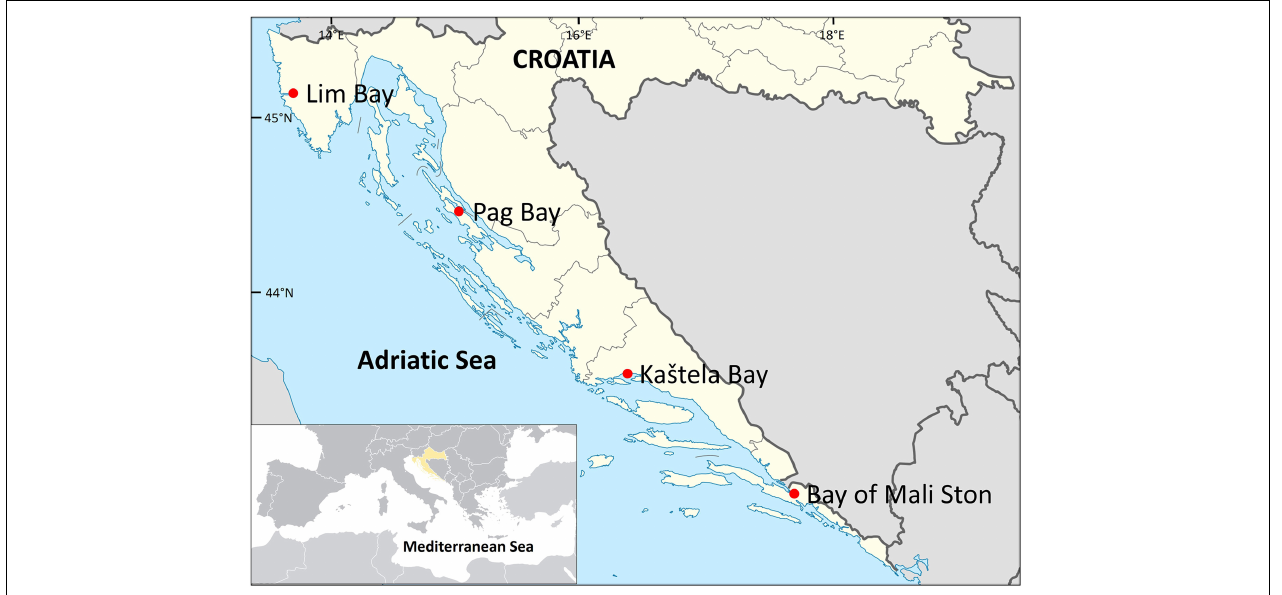
FIGURE 1 | Map of the Adriatic Sea showing sample localities (red